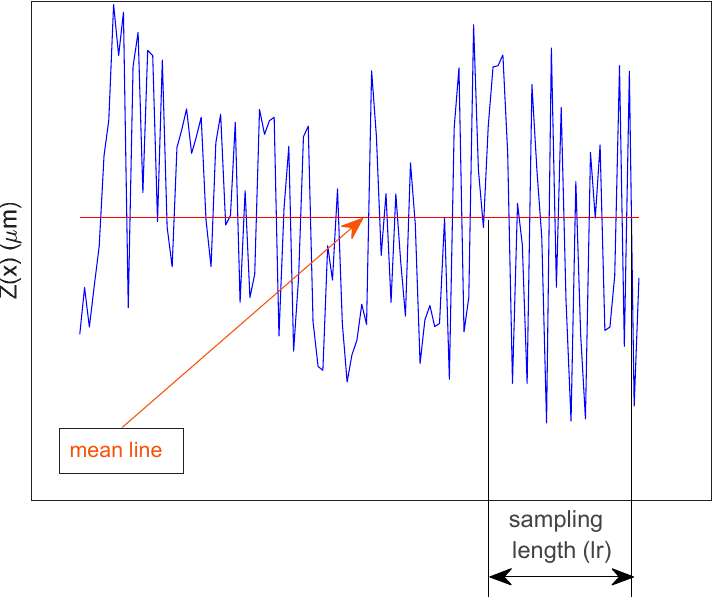
Figure 2. Roughness profile for determination of Ra parameter.